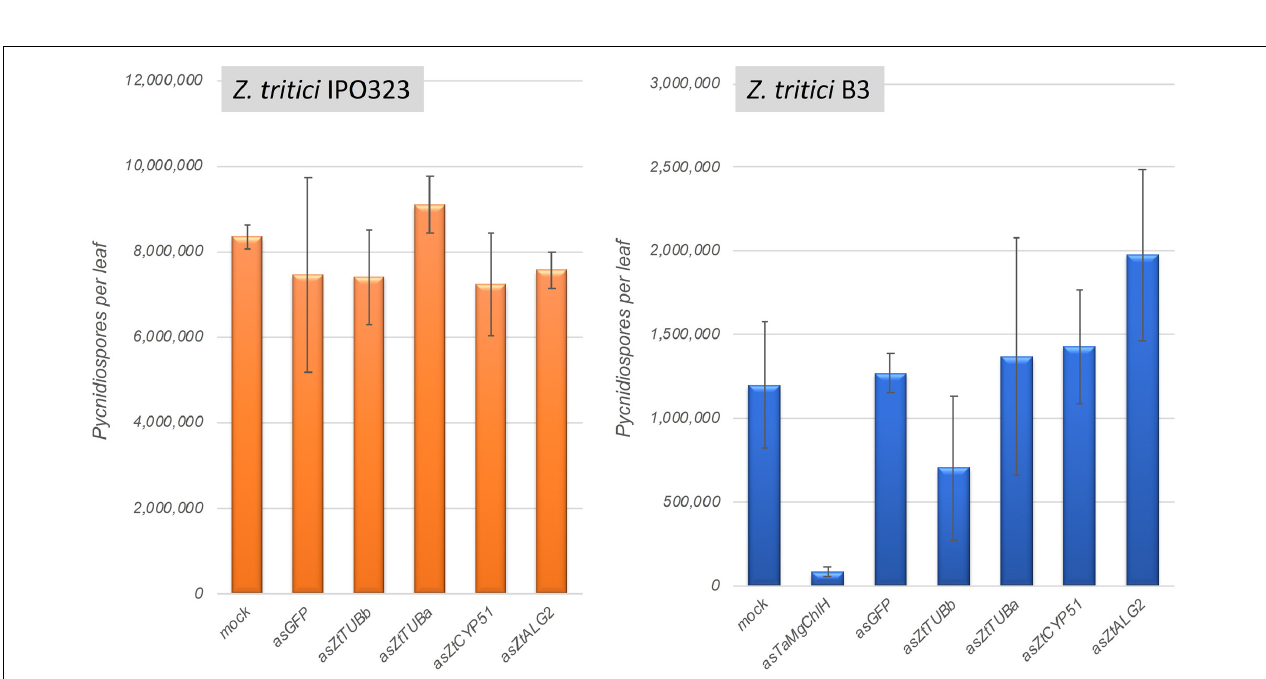
FIGURE 6 | Assessment of Zymoseptoria tritici strains IPO323 and B3 pycnidiospore production in wheat cv. Riband plants pre-treated with various BSMV-HIGS and BSMV-VIGS constructs.